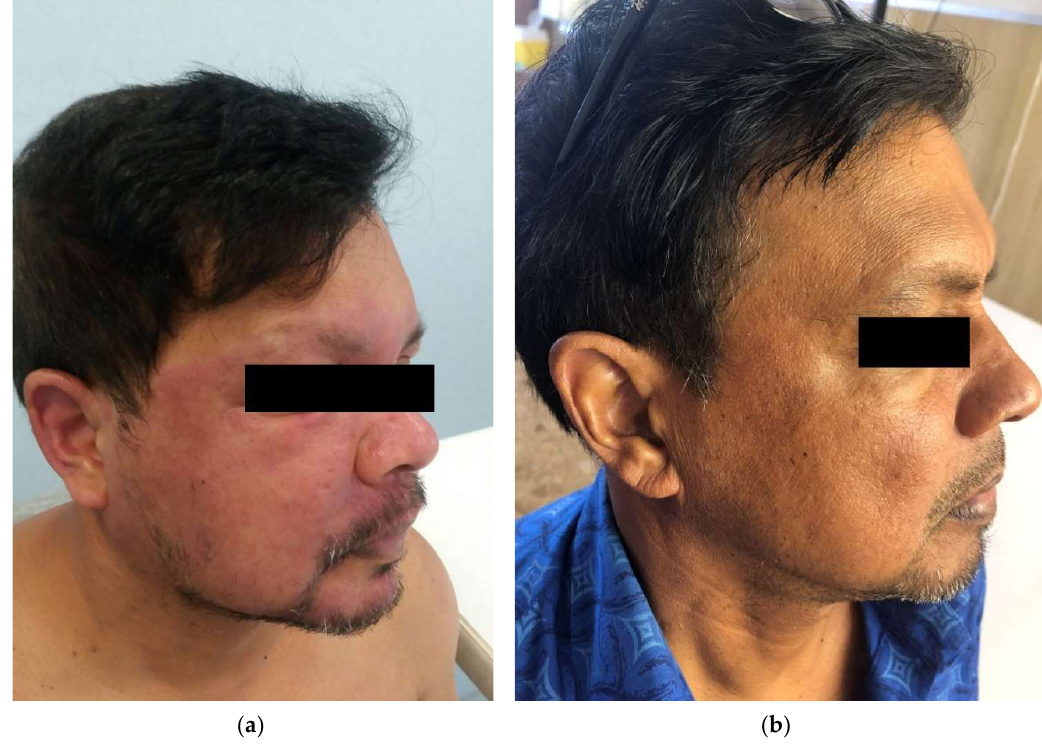
Figure 4. ( a ) Erythematous-infiltrated and edematous plaque edema symmetrically distributed over the face (with raised margins) and conjunctivitis (Type 1 reaction) in a 46-year old migrant from Bangladesh with a diagnosis of borderline lepromatous leprosy. ( b ) The plaque resolved after combination treatment with multidrug therapy and steroid.